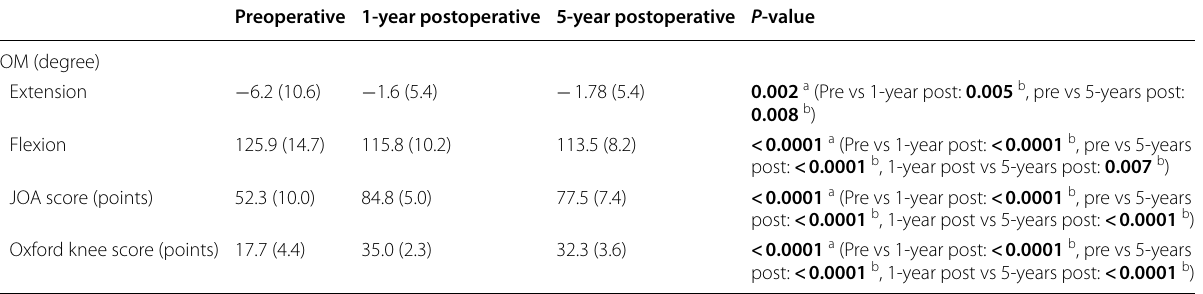
Data are reported as mean (standard deviation), unless otherwise indicated. Bolded P -values indicate statistical significance ( P < .05) JOA score Japanese Orthopedic Association score for osteoarthritic knee, ROM range of motion a One-way analysis of variance b Significant difference between preoperative, 1-year postoperative, and 5-year postoperative groups (post hoc Tukey–Kramer